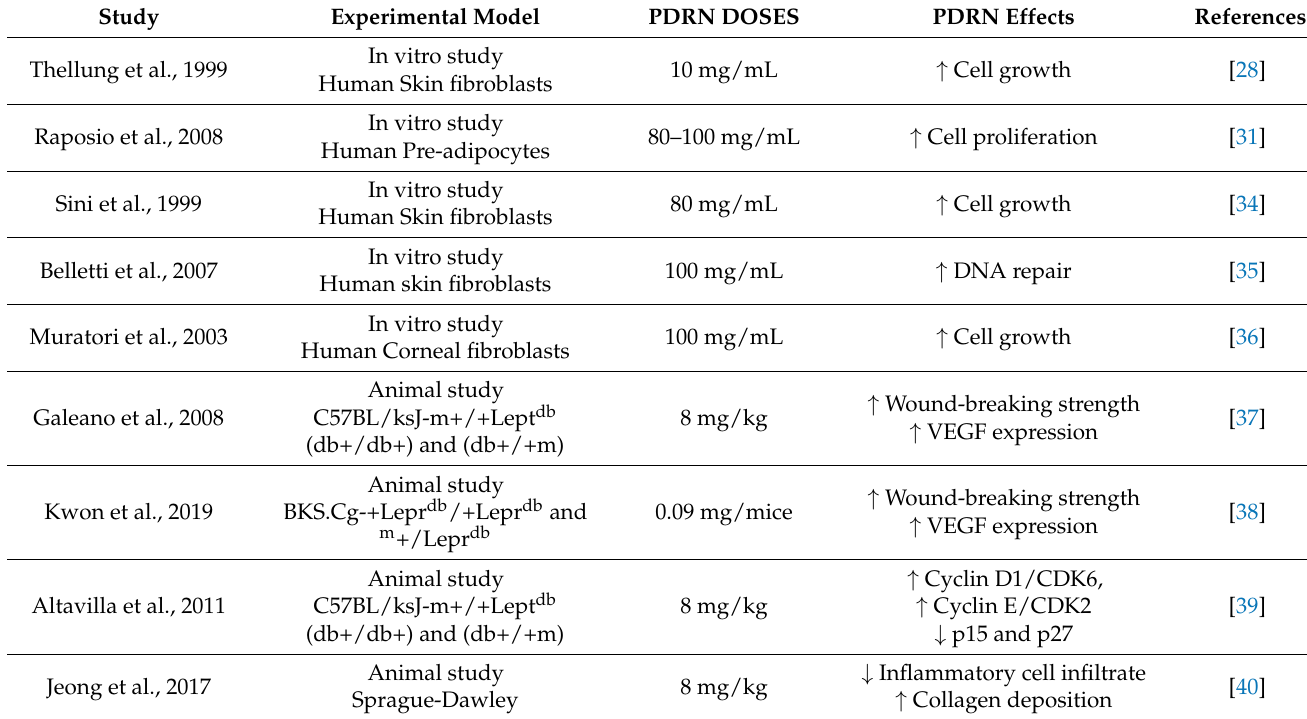
Table 1. The table summarizes the in vitro, in vivo and clinical studies investigating the effects of polydeoxyribonucleotide on wound